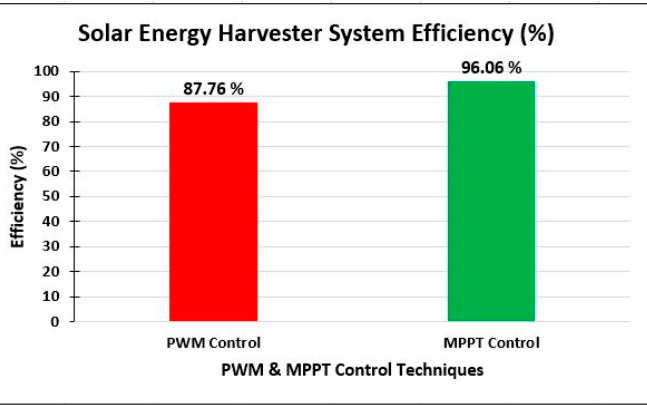
(cid:0) (cid:1) η sys .